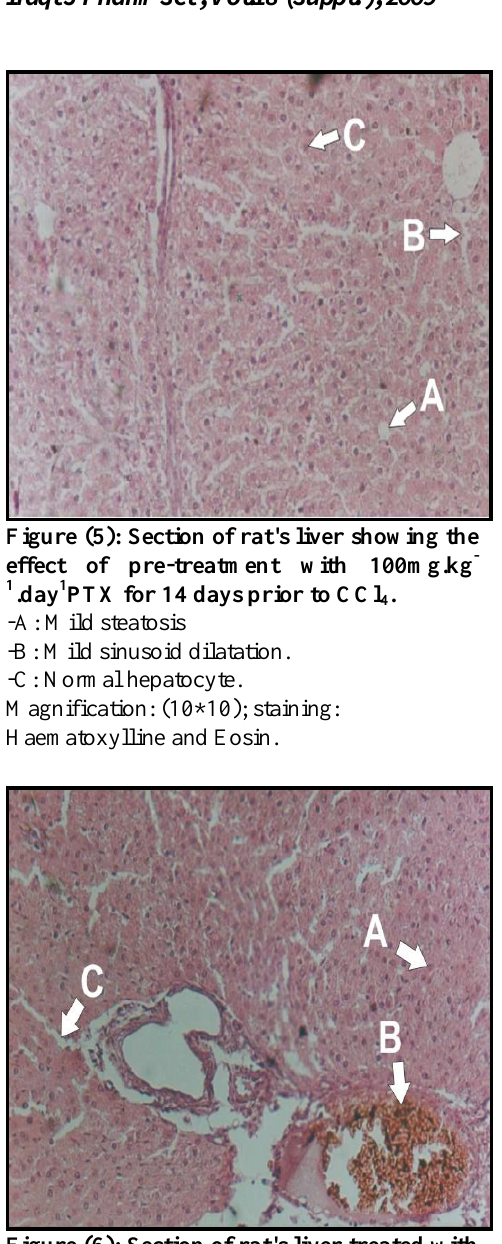
Figure (6): Section of rat's liver treated with 100mg.kg -1 .day -1 PTX alone for 14 days. -A: Normal hepatocyte -B: Congestion . -C: Mild sinusoid dilatation. Magnification: (10*10); staining: Haematoxylline and